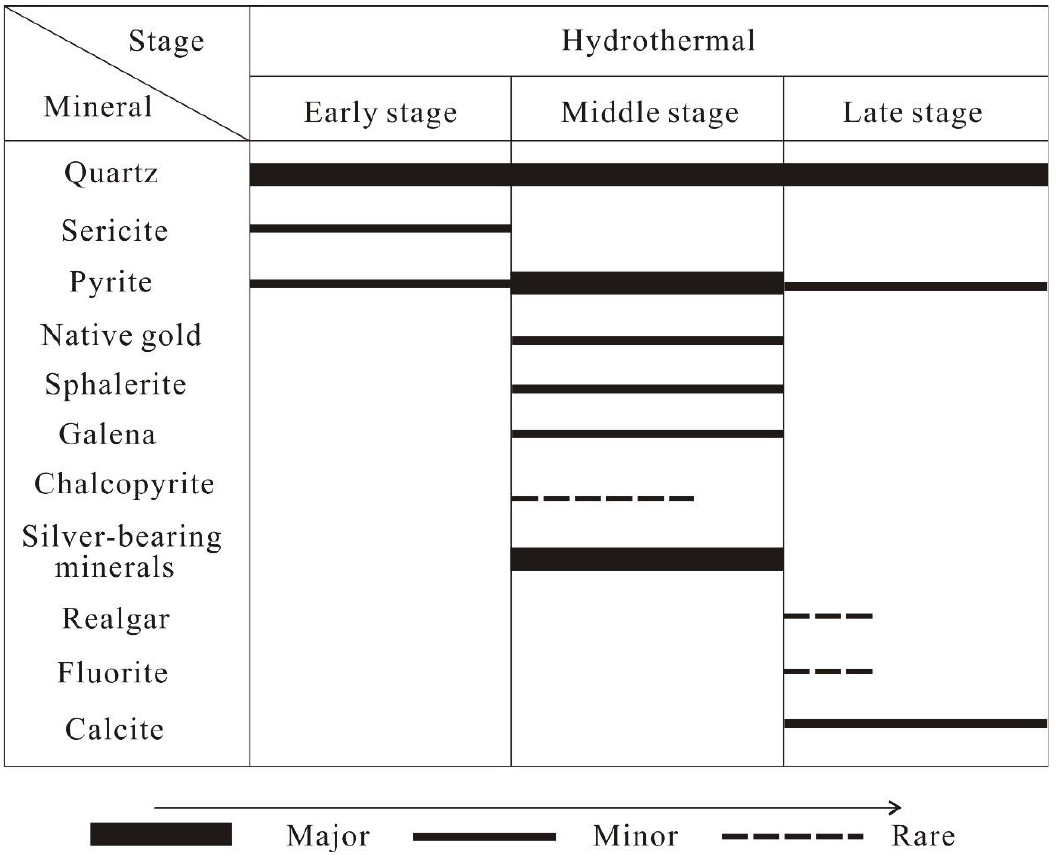
Figure 6. Paragenetic sequence for major minerals of the Changkeng – Fuwan Au-Ag gold deposit.